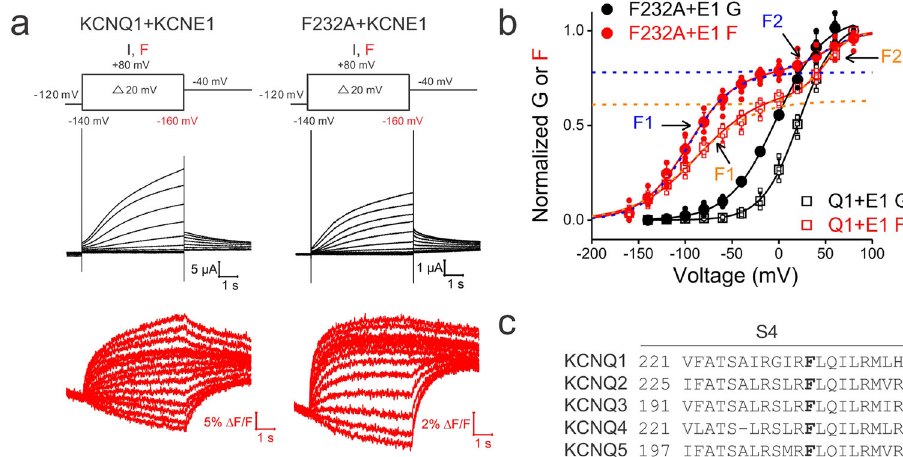
Fig. 2 F232A allows KCNQ1/KCNE1 to open before voltage sensors are in the fully activated state. a Current (black) and fl uorescence (red) traces from oocytes expressing KCNQ1/KCNE1 and KCNQ1-F232A/KCNE1 channels. Cells are held at − 120 mV and stepped to voltages between − 140 mV ( − 160 mV for fl uorescence) and + 80 mV in + 20 mV followed by a step to − 40 mV. b Voltage dependence of currents (black) and fl uorescence (red) from KCNQ1/ KCNE1 (squares) and KCNQ1-F232A/KCNE1 (circles) channels. The GV relation was fi tted with a single Boltzmann equation while the FV relation was fi tted with a double Boltzmann equation. F1 and F2 indicate the fi rst and second fl uorescence components from KCNQ1/KCNE1 (orange dashed lines) and KCNQ1-F232A/KCNE1 (blue dashed lines) channels, respectively. c Sequence alignment of S4 in KCNQ family. F232 in KCNQ1 channels is conserved among other KCNQ channels. Data are shown as mean ± SEM. N is shown in Supplementary Table 1.